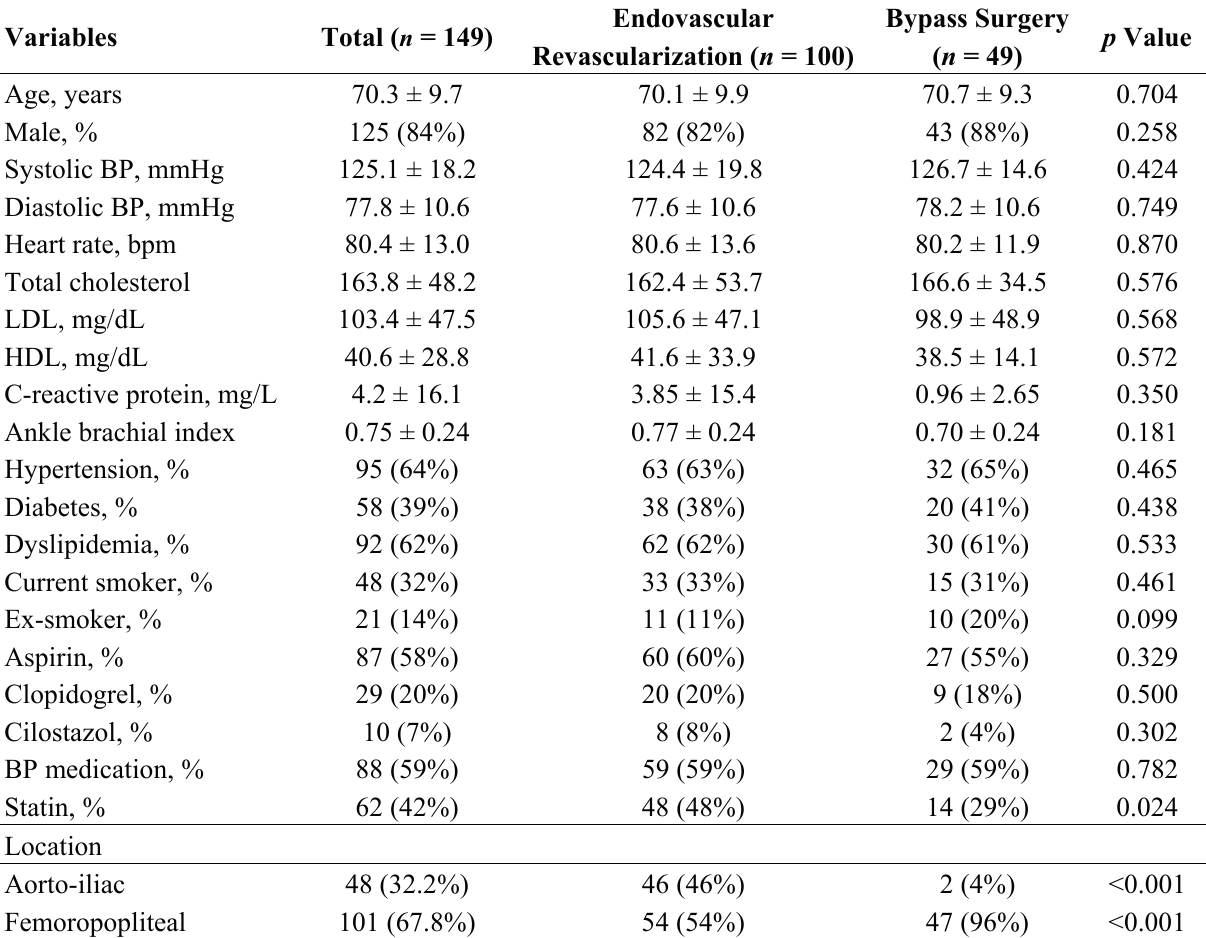
Table 1. Baseline characteristics of enrolled PAD